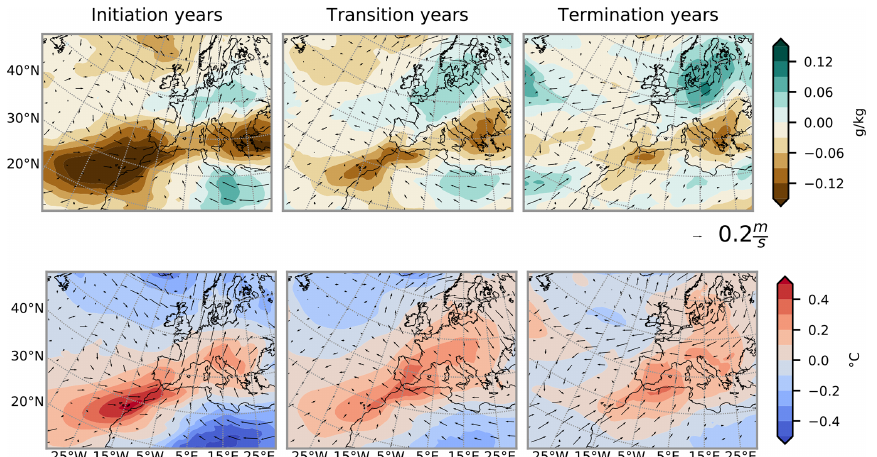
Figure 11. Evolution of atmospheric conditions in each stage of drought. Anomalies of (above) specific humidity and (below) temperature, both at 925hPa during the initiation, transition, and termination years of droughts. Arrows indicate winds at 925hPa.